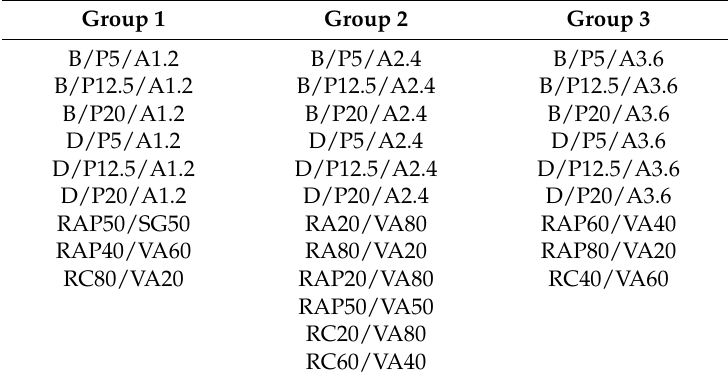
Table 4. List of recycled mixtures after preliminary classification in clusters